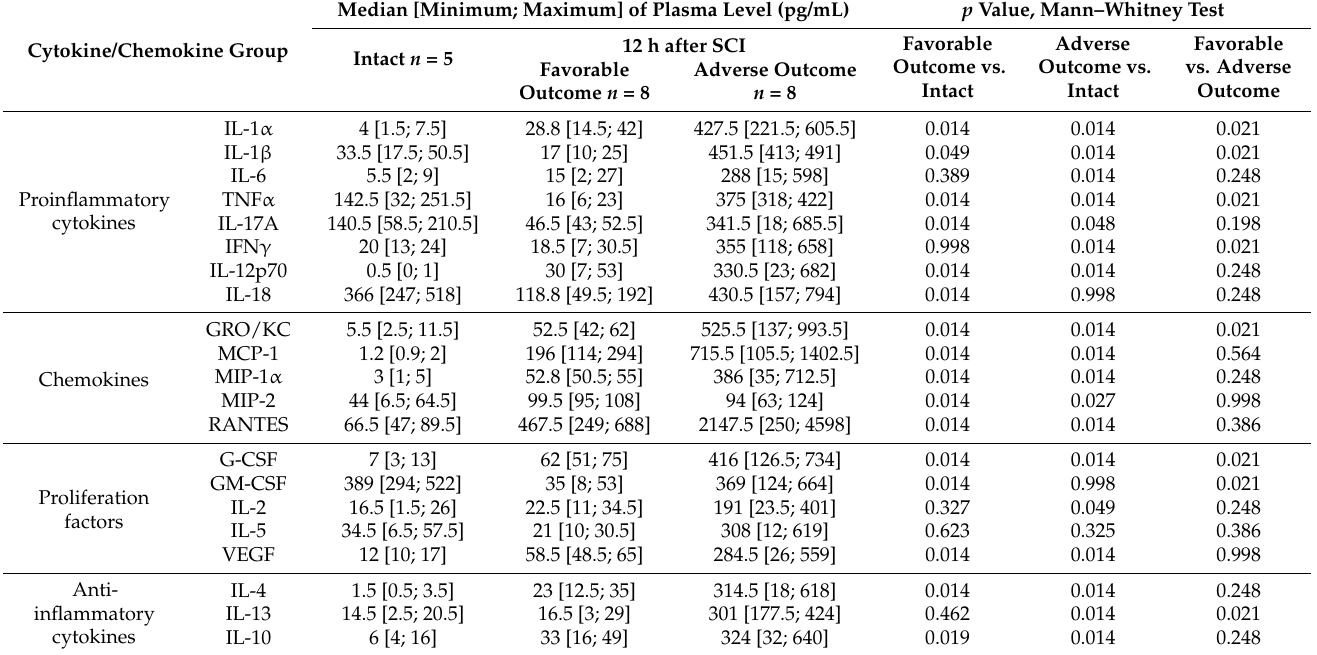
Table 2. Cytokine profile of blood plasma from animals with spinal cord cryoinjury. Median [Minimum; Maximum] of Plasma Level Cytokine/Chemokine Group